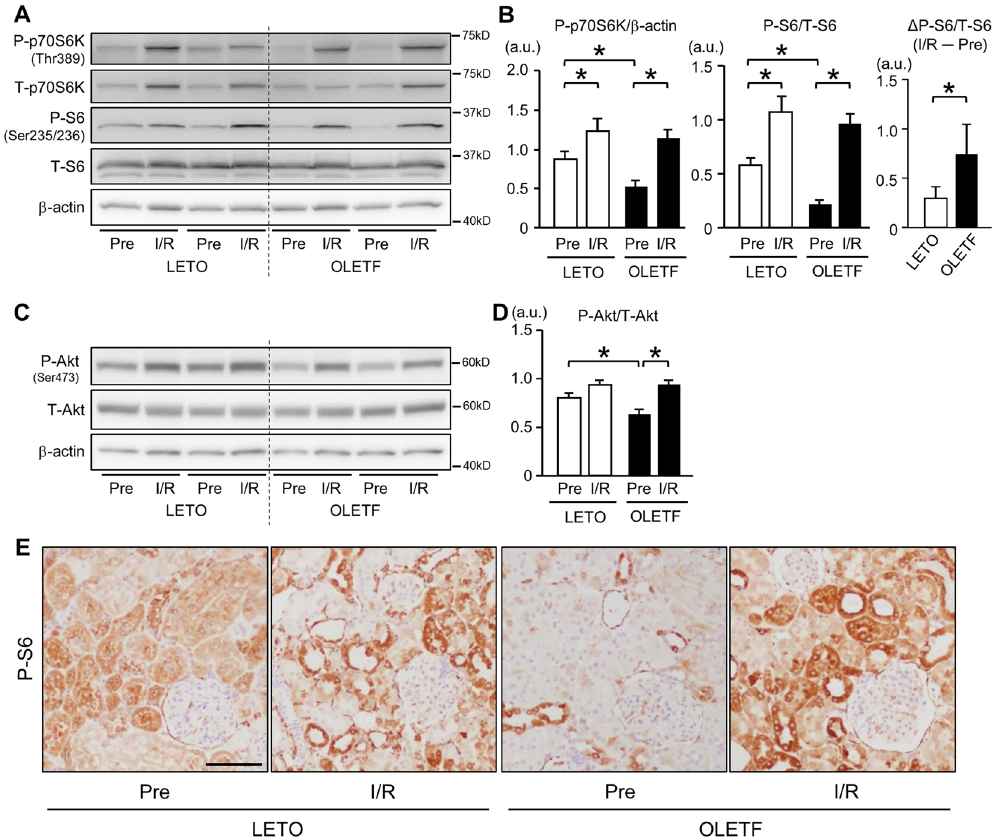
Figure 5. Analysis of Akt/mTORC1 signal pathways. Representative immunoblots ( A ) and summary data ( B ) for phospho-Thr389 and total p70S6 kinase (p70S6K), phospho-Ser235/236 and total S6, and actin in renal tissues before ischemia and 24 h after reperfusion in LETO and OLETF. Pre: pre-ischemia, I/R: 24 h after ischemia/reperfusion. ( B ) Before ischemia, phospho-p70S6K and phospho-S6 levels were reduced in OLETF. Levels of phospho-p70S6K and phospho-S6 were increased after I/R in both groups. The change in phospho-S6 level ( Δ P-S6/T-S6) from the pre-ischemic period to 24 h after I/R was greater in OLETF than in LETO. ( C ) Representative immunoblots for phospho-Ser473 and total Akt. ( D ) Phospho-Akt level before ischemia was lower in OLETF than in LETO. I/R increased phospho-Akt levels in both OLETF and LETO, and phospho- Akt levels after I/R were similar in LETO and OLETF. N = 8 in each group. ( E ) Representative images of immunostaining for phospho-S6 in kidney sections before and 24 h after ischemia/reperfusion in LETO and OLETF. Scale bar, 100 μ m. * P <